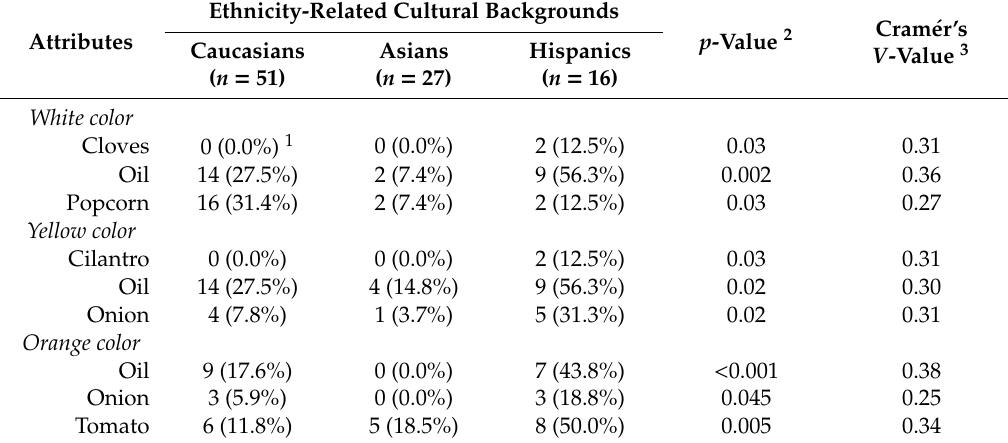
Table 2. A contingency table of the proportions of selection by Caucasian, Asian, and Hispanic participants for individual sensory attributes in the four cooked-rice samples with di ff erent surface